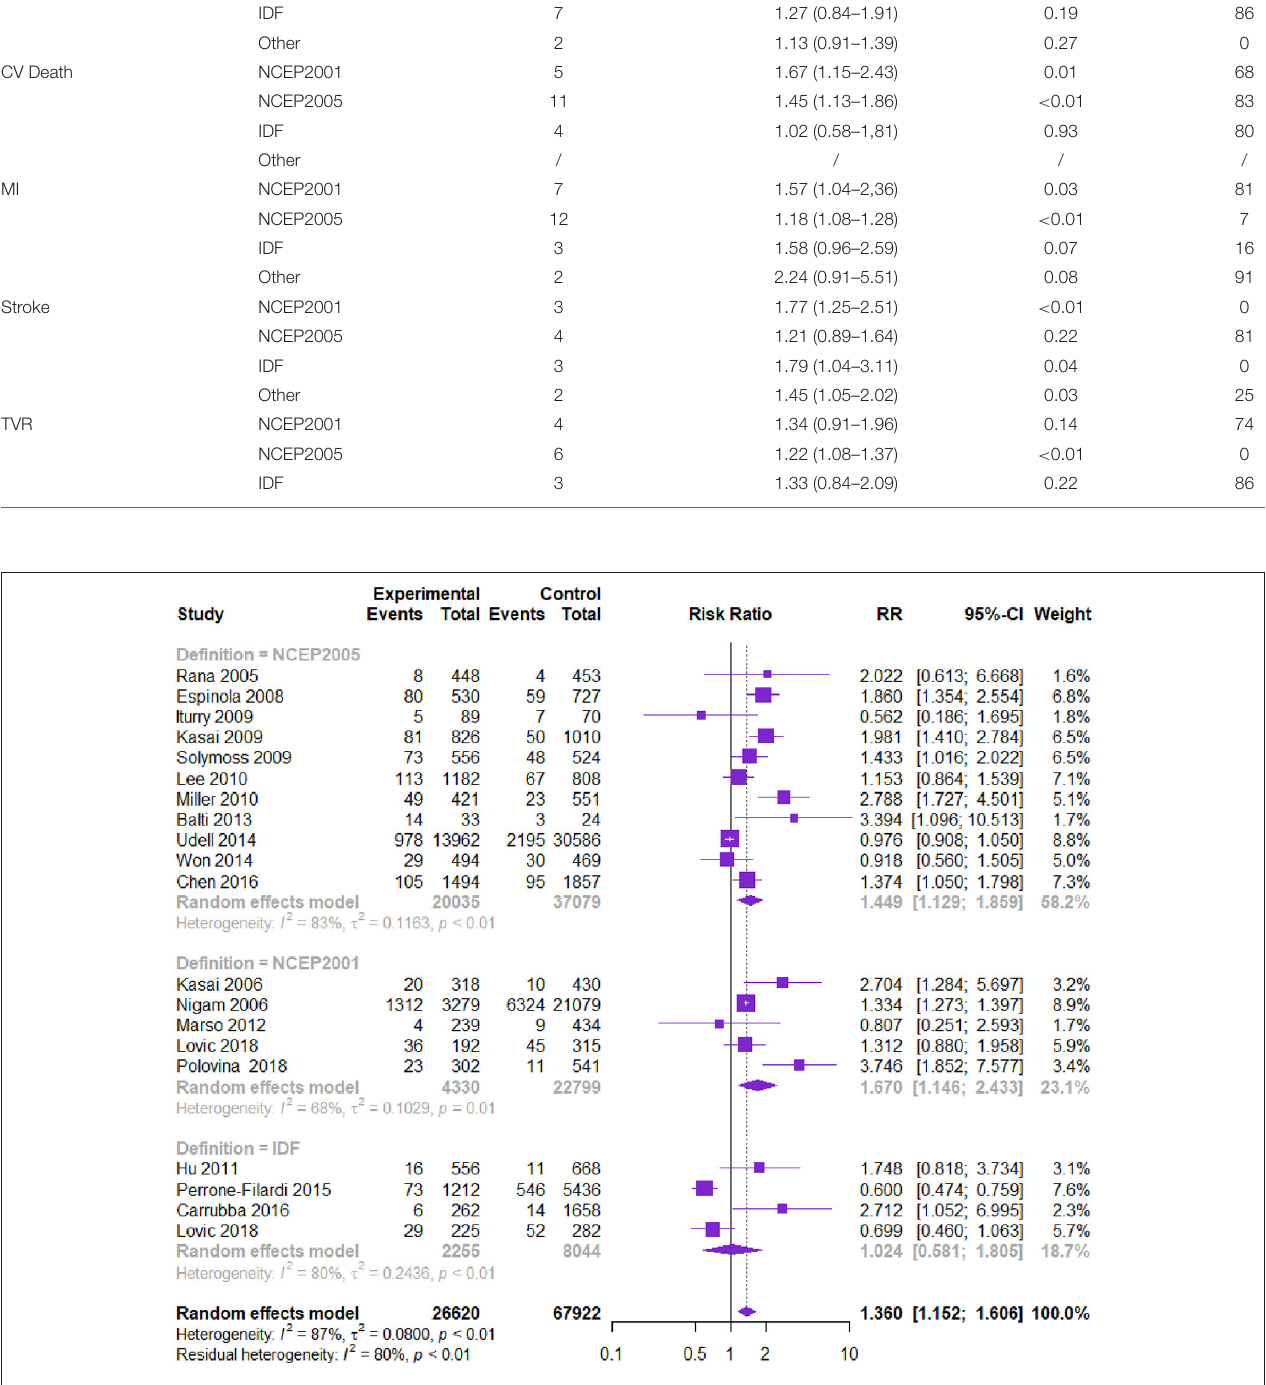
Frontiers in Cardiovascular Medicine |